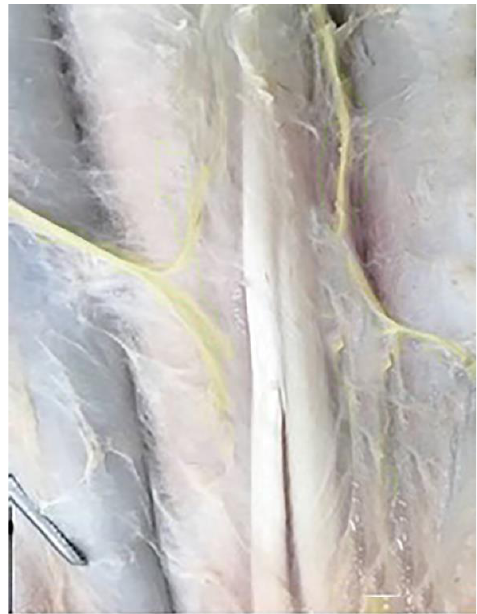
Figure 8. Cutaneous nerves of the medial and lateral surface of the metatarsus region in camels.